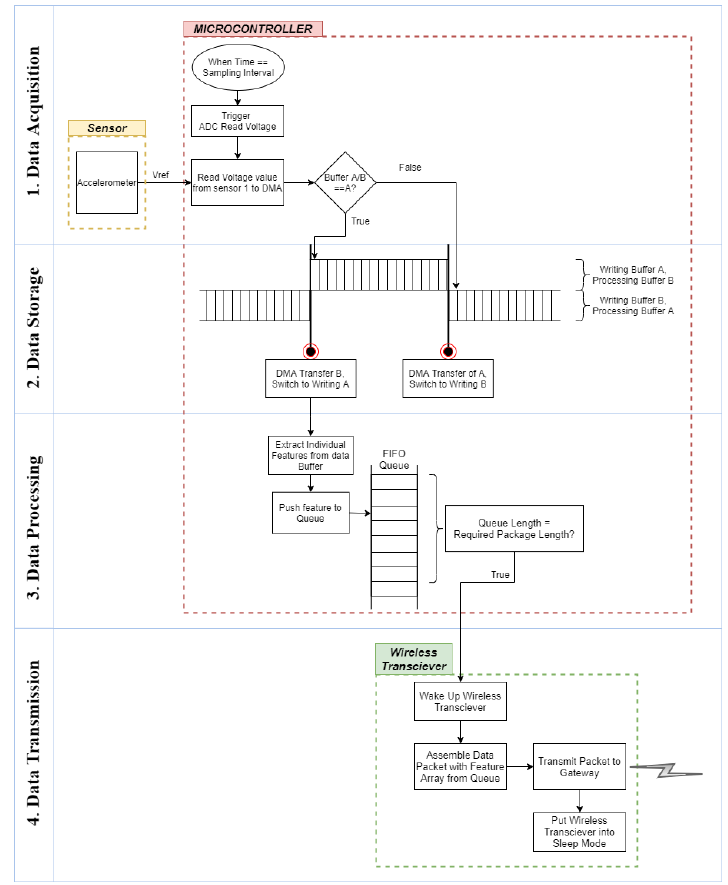
Figure 1. Edge device data flow.